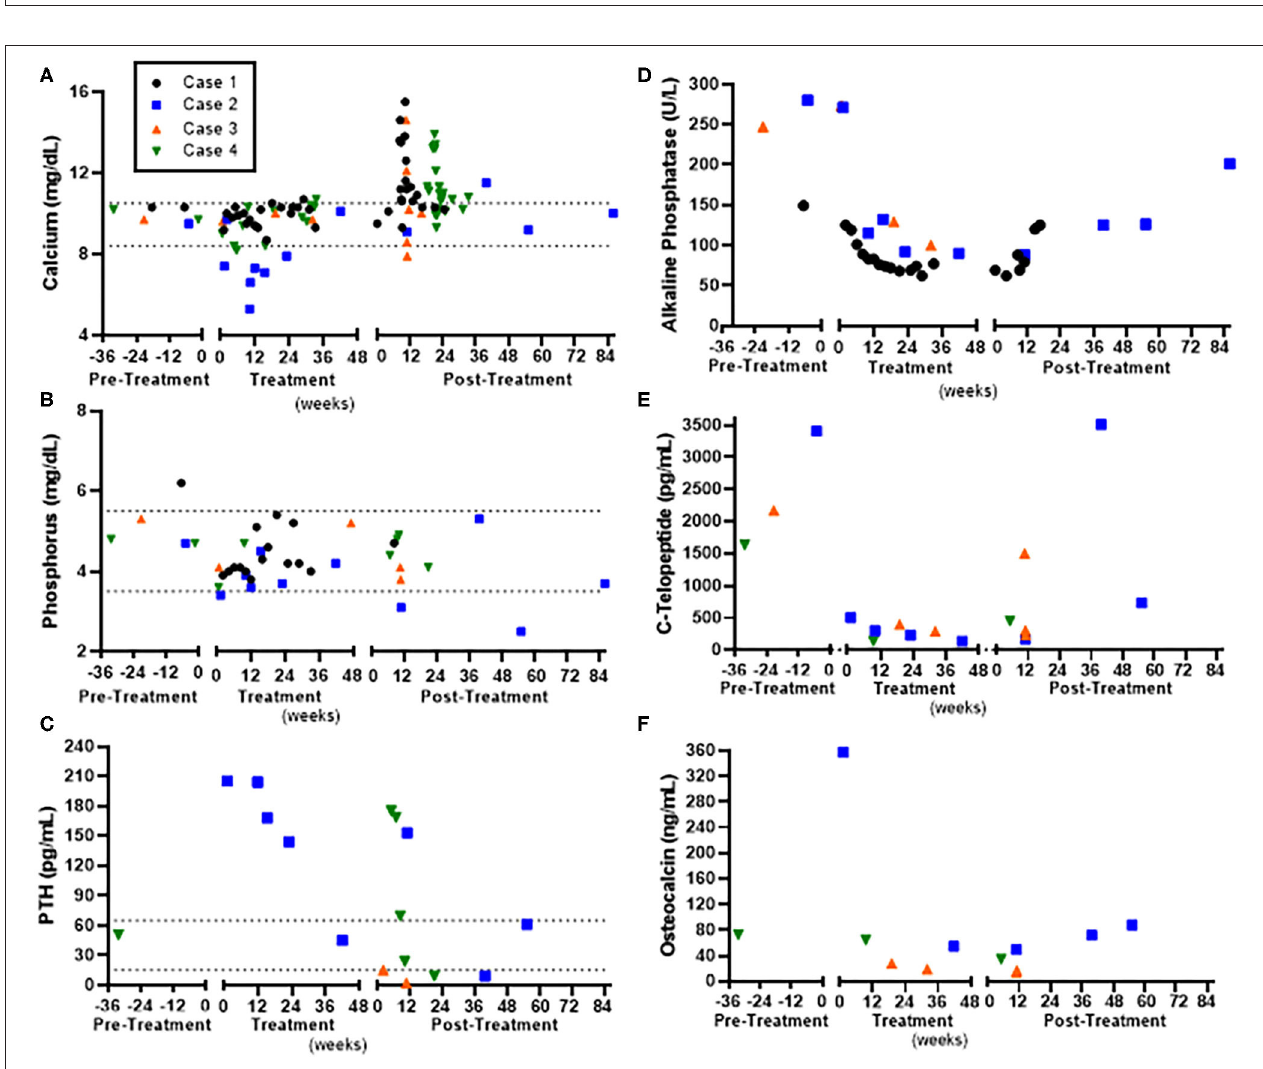
FIGURE 1 | imaging (MRI) (D) at the level of mandibular molars relative to post-denosumab (E–H) 3D CT reconstruction of frontal (E) and profile (F) views, axial CT without contrast (G) 8 months after initial denosumab treatment, and axial magnetic resonance imaging (MRI) (F) at the level of mandibular molars 15 months after second denosumab treatment. (I–L) Case 2 dental orthopantomogram at baseline (I) and after on denosumab for 6 (J) , 12 (K) , and 18 (L) months. (M, N) Case 3: dental orthopantomogram at baseline (M) and after on denosumab for 5 months (N) . (O,P) Case 4: baseline axial (O) and coronal (P) CT without contrast at level of mandibular molars. Red arrows and circles denote NL/MGCLs.